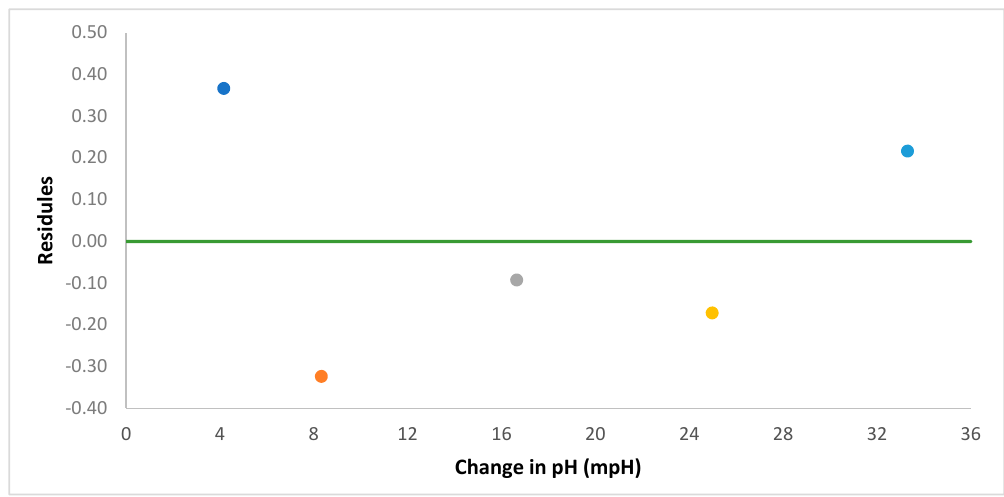
Figure 14. Residual plot of the data of glucose concentration that plotted against the measured change in pH.